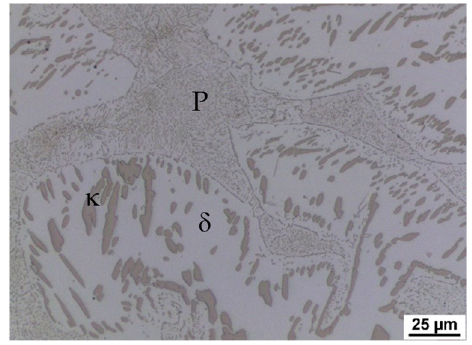
Figure 4. Casting structure of heat C. P—pearlite, κ —kappa phase, δ —ferrite.